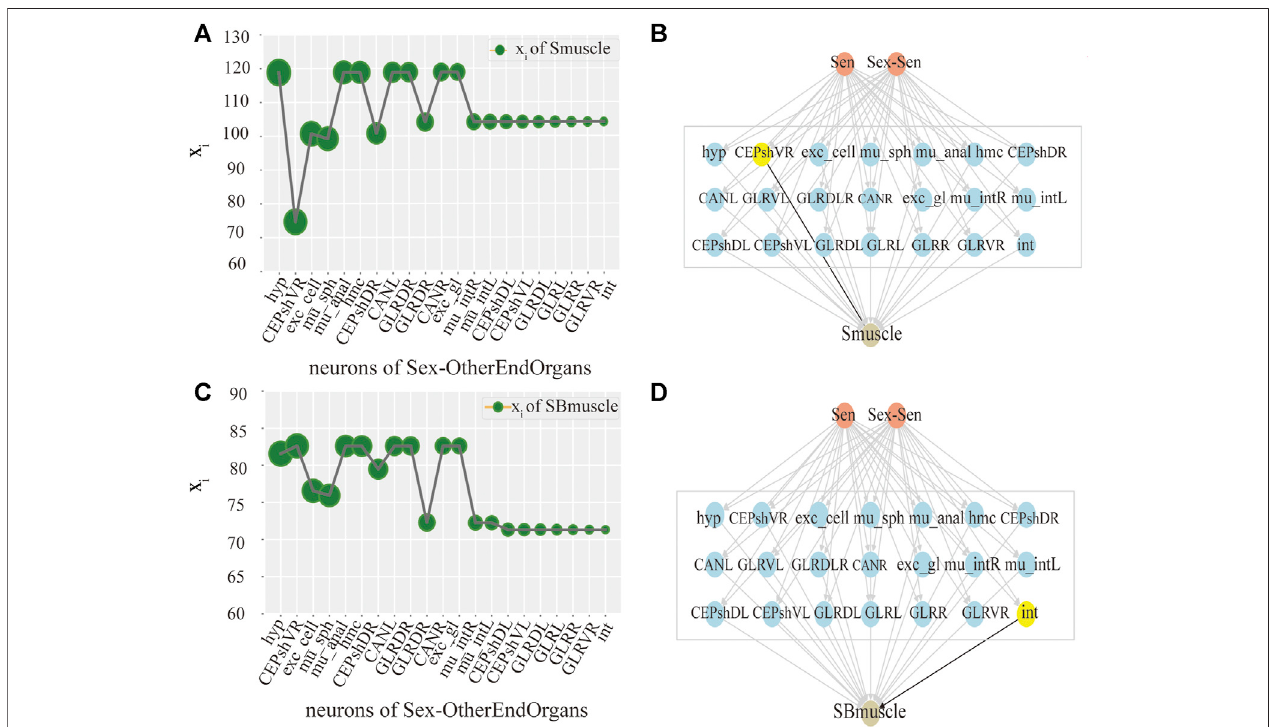
FIGURE 3 | Control analysis of single neuron in male C.elegans . (A) Activity line chart of SBmuscle, after neuronal perturbation of the Sexotherorgan intermediate neuronalgroup inthe male C.elegans bydegree. Degree refers to the degree ofthe node in thisnematode network, we calculated degree and sorted them. The order is shown in fi gure: The size of the green circle represents the size of degree, same as below. (B) Control model of SBmuscle by the Interneuron group of Sexotherorgan. The neurons with maximum control are shown in yellow color, same as below. (C) Activity line chart of Smuscle, after neuronal perturbation of the Sexotherorgan intermediate neuronal group in the male C.elegans by degree. (D) Control model of Smuscle by the Interneuron group of Sexotherorgan. (SensoryNeurons:Sen; SexSpeci fi cCells-SensoryNeuron:Sex-Sen; SexSpeci fi cCells -InterNeurons:Sex-Inter; SexSpeci fi cCells -OtherEndorgans: Sex- OtherEndOrgans. Same as the others).